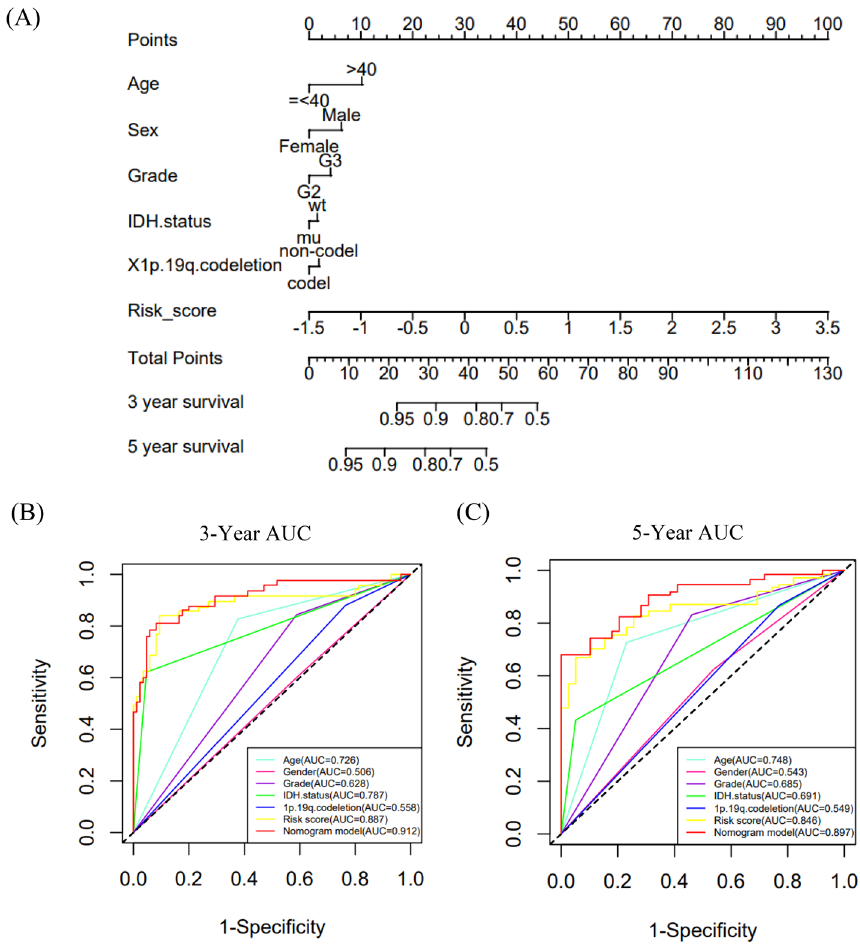
Figure 6. The nomogram to predict 3 ‐ or 5 ‐ year OS in LGGs. ( A ) A nomogram to predict the 3- and 5-year OS of LGGs patients treated with radiotherapy in the TCGA dataset. ( B , C ) ROC curves comparing the prediction accuracy of each factor in the